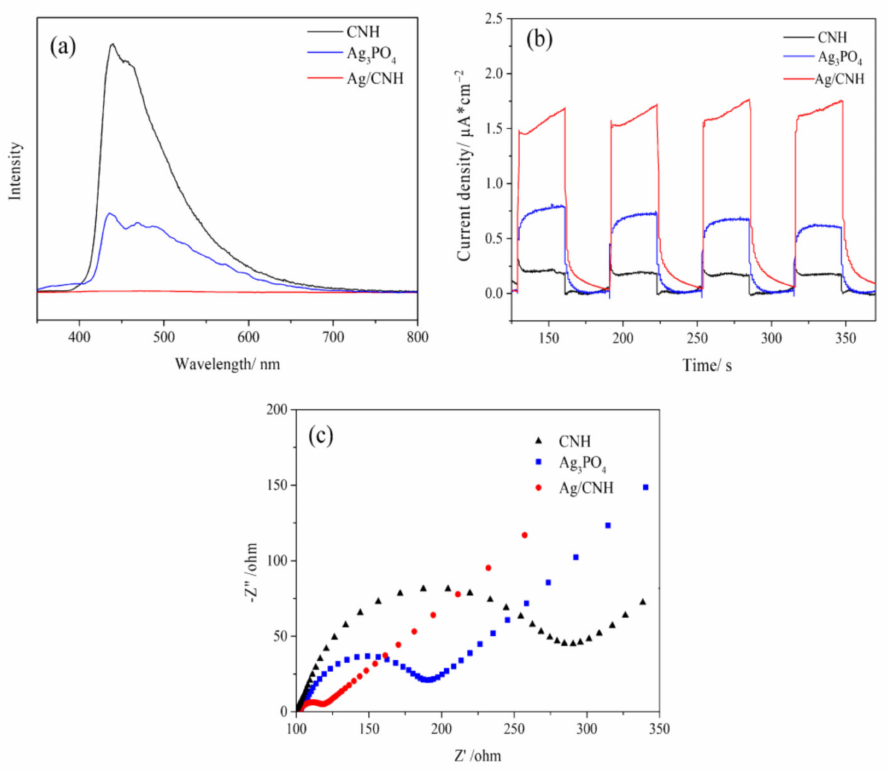
Figure 6. ( a ) Steady-state PL emission spectra, ( b ) transient photocurrent curves, and ( c ) EIS spectra of CNH(III), Ag 3 PO 4 and